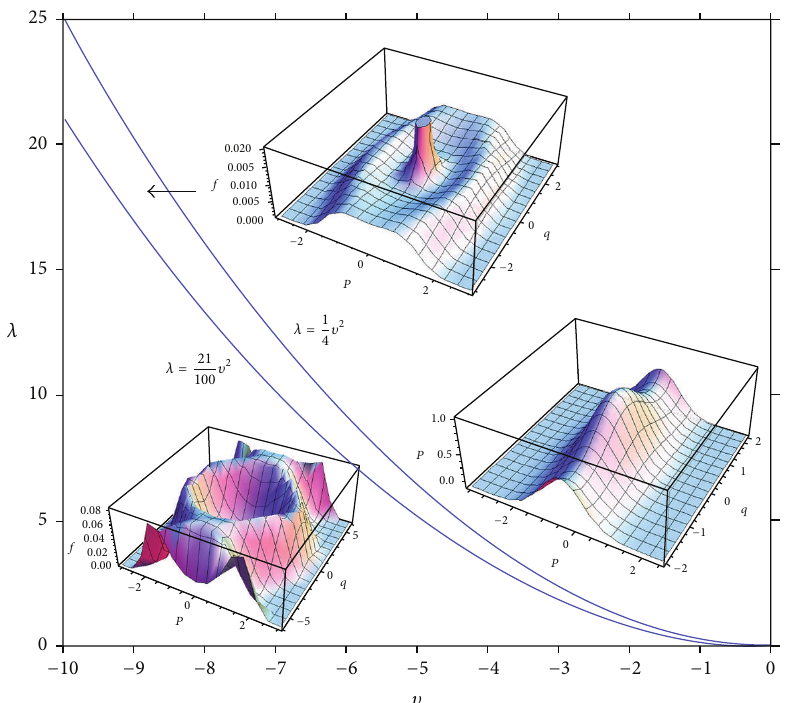
Figure 7: Stationary probability density (SPD) of the system response in different